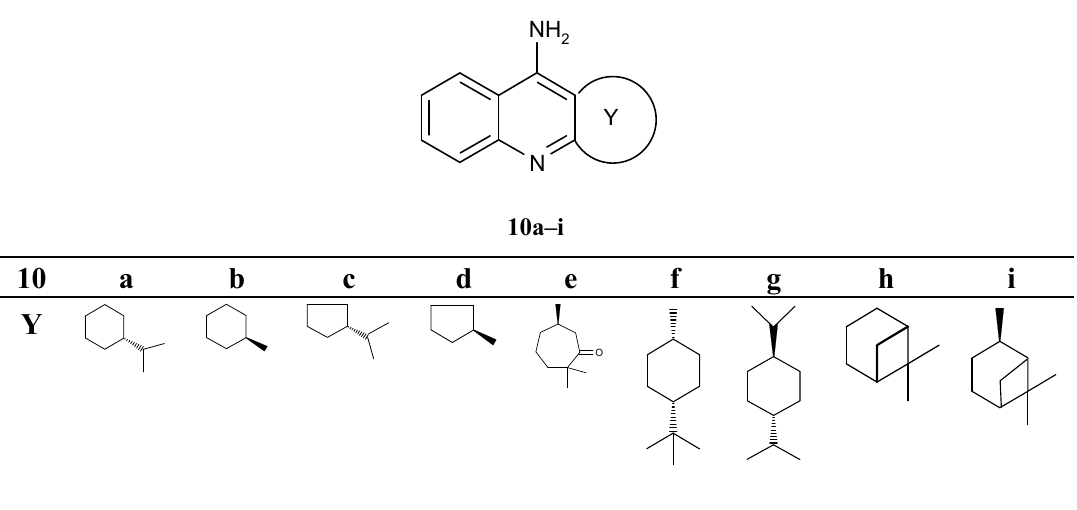
Figure 4. Terpenic chiral 9-aminotetrahydroacridine analogues 10a–i